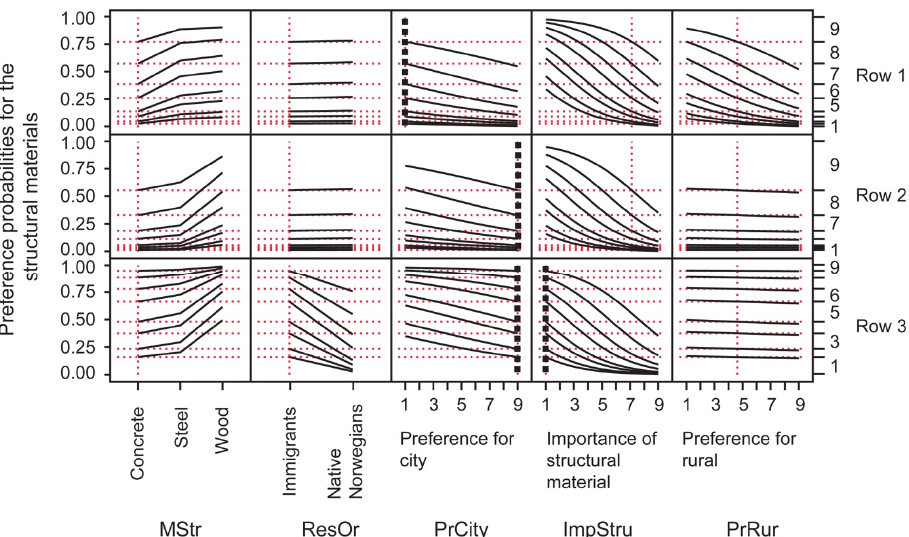
Figure 3. Profile plots showing the preferences for different structural materials, depending on the values of various independent variables in Model 1. The profile plots show the preferences for different structural materials, depending on the values of various independent variables in Model 1 (Table 3). Three rows of plots are included to show how the preferences for the different structural materials change with changes in the independent variable values. The thick vertical dashed lines indicate where the researcher set the value of the independent variables. The distances between the horizontal lines in the first column of plots show the probability for the different preference values. The probability for preference 9 is the distance between the upper most line and 1.00. The distance between lines 7 and 8 shows the probability for preference value 8. The probability for the lowest preference value is between 0.00 and the lowest line. For example, in row 2, column 1, approximately 40% of the respondents rated their preference for concrete as the highest value of 9, given by the independent variables setting values, as shown by the vertical dashed lines. Although some of the data in Figure 2 is categorical, the lines between categories are provided only for the ease of the visual interpretation of changes in level from one category to the next. This figure text is partly the same as the figure text in Figure 1 in the article of Høibø et al.